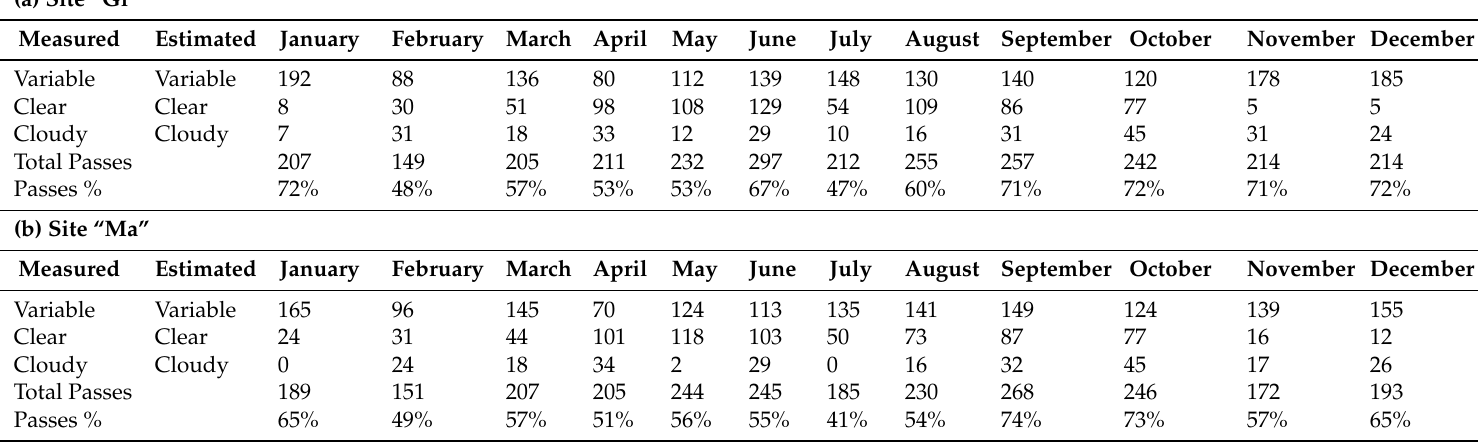
Table 2. Number of passes for all the months of